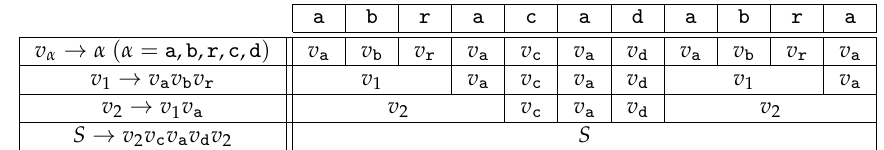
a , b , r , c , d a , v b b , v r r , v c v a , , S , } { } { → → →